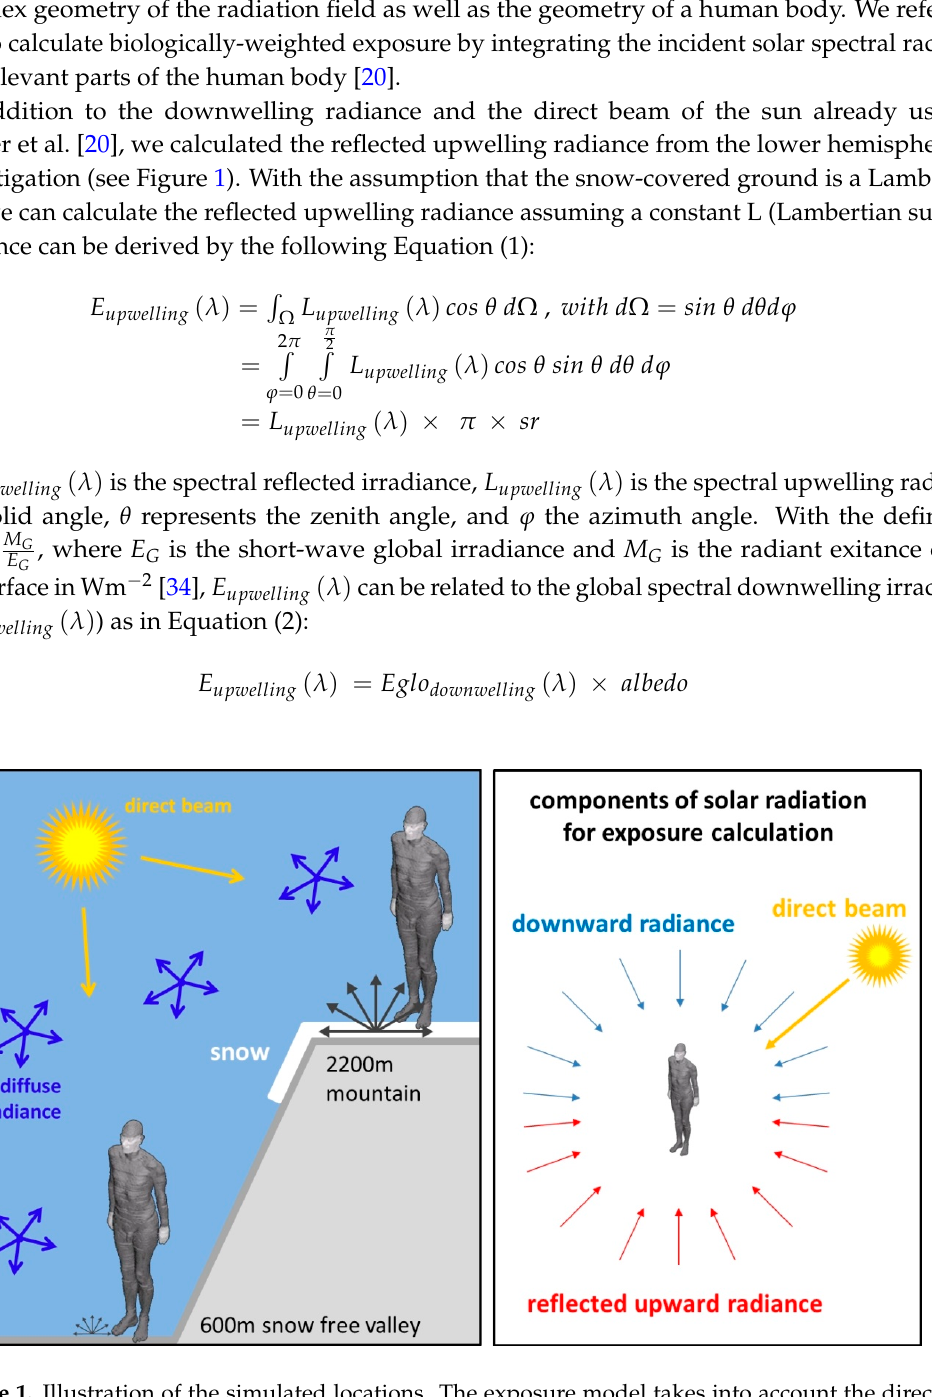
Figure 1. Illustration of the simulated locations. The exposure model takes into account the direct, diffuse, and reflected radiations, the complex geometry of a human body, and clothing. The albedo values of the location at 2200 m have been varied from 0.02 to 0.6. For a lower-altitude location at 600 m, an albedo of 0.02 was used. Figure 2 depicts simulated values of the irradiance and the exposure for the valley location at 600 m, as well as for the mountain top location at 2200 m for 31 March 2016 with a solar zenith angle (SZA) of 45°. All mountain values are greater than the valley values. However, the albedo has a greater influence on the exposure than on the irradiance.